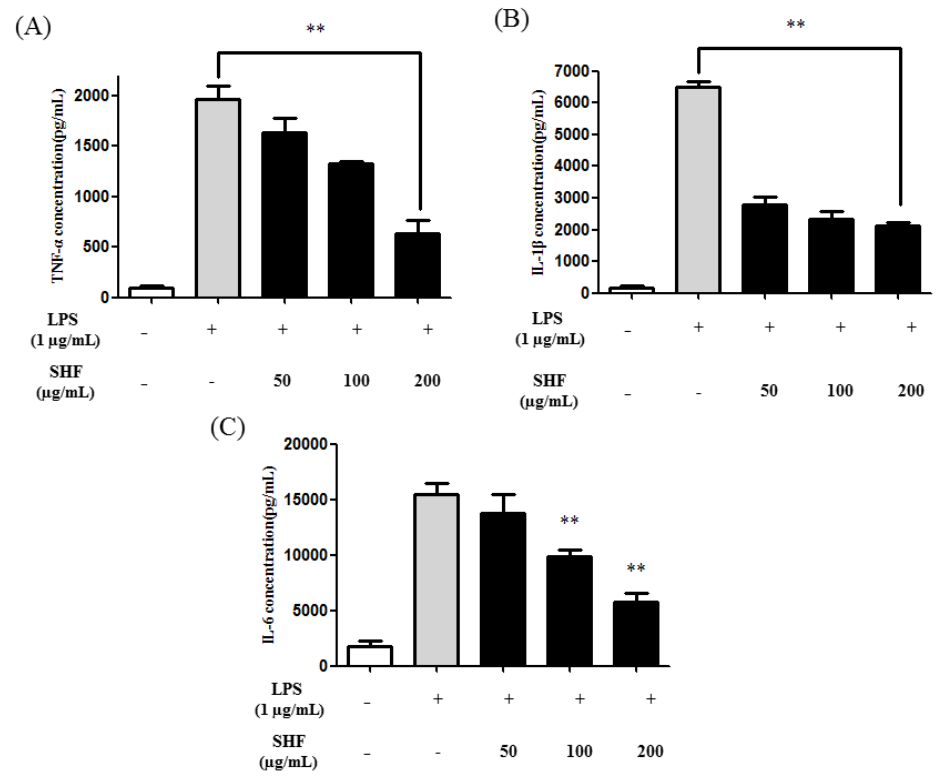
Figure 6. Effect of the Stauntonia hexaphylla fruit (SHF) extract on the production of pro-inflammatory cytokines in RAW 264.7 cells. The production of ( A ) tumor necrosis factor (TNF)- α ; ( B ) interleukin (IL)-1 β ; and ( C ) interleukin IL-6 was assayed in the culture medium of cells treated with 50, 100 and 200 µg/mL of the SHF extract and later treated with LPS (1 µg/mL) for 18 h. The concentrations of TNF- α , IL-1 β, and IL-6 in the supernatants were determined by enzyme-linked immunosorbent assays. Data are presented as means ±SD. ** p < 0.01 compared to the LPS-stimulated group (ANOVA followed Dunnett’s test).